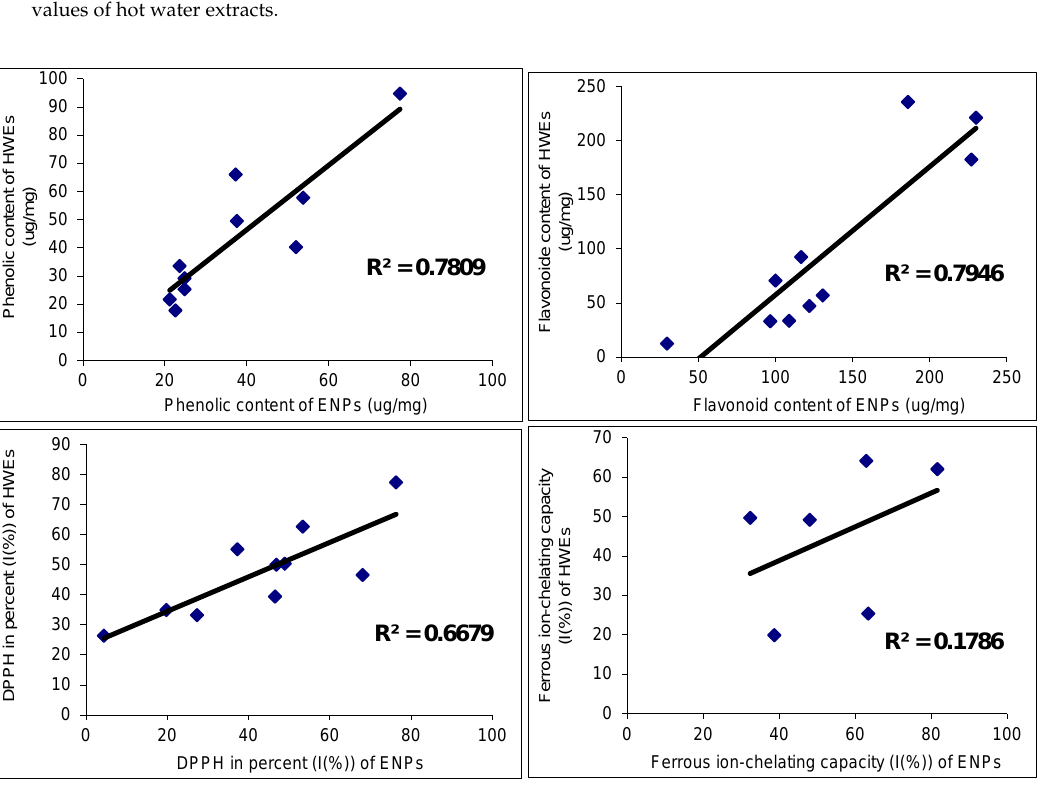
Figure 2. Correlation R 2 values of phenolic and flavonoids contents, and DPPH and ferrous ion-chealting activities between the endopolysaccharides and hot water extracts.